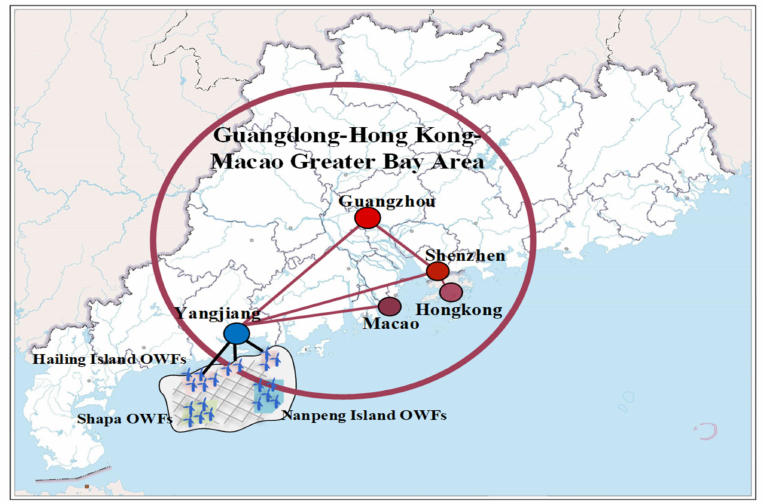
Figure 1. Overview of the study